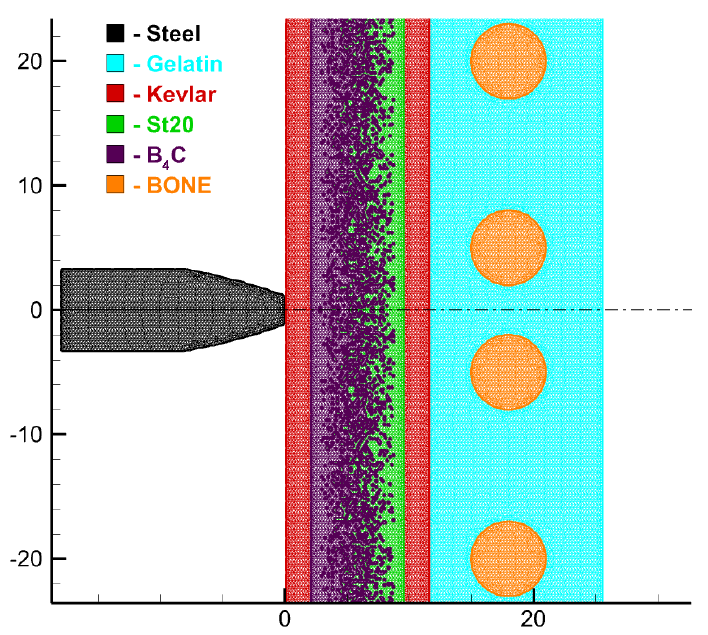
Fig. 4. The protective plate of a gradient material obtained by a linear distribution of the concentration of ceramics in steel, model